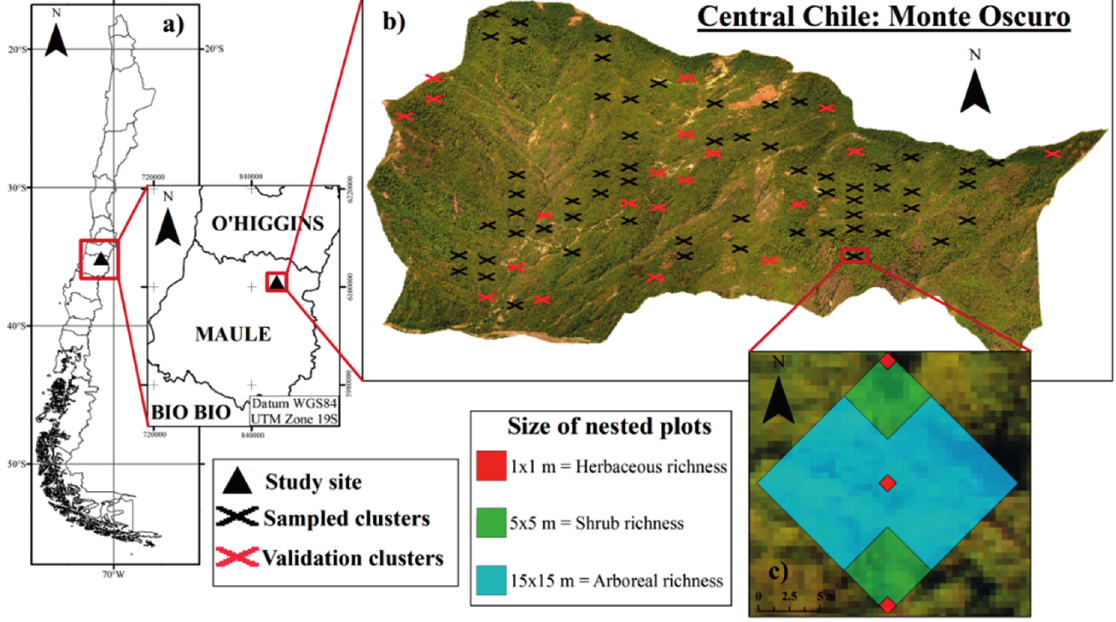
Figure 6. ( a ) Location of the study area; ( b ) Spatial distribution of field samples (model clusters in black and validation clusters in red); ( c ) Detail of a sampling unit with nested